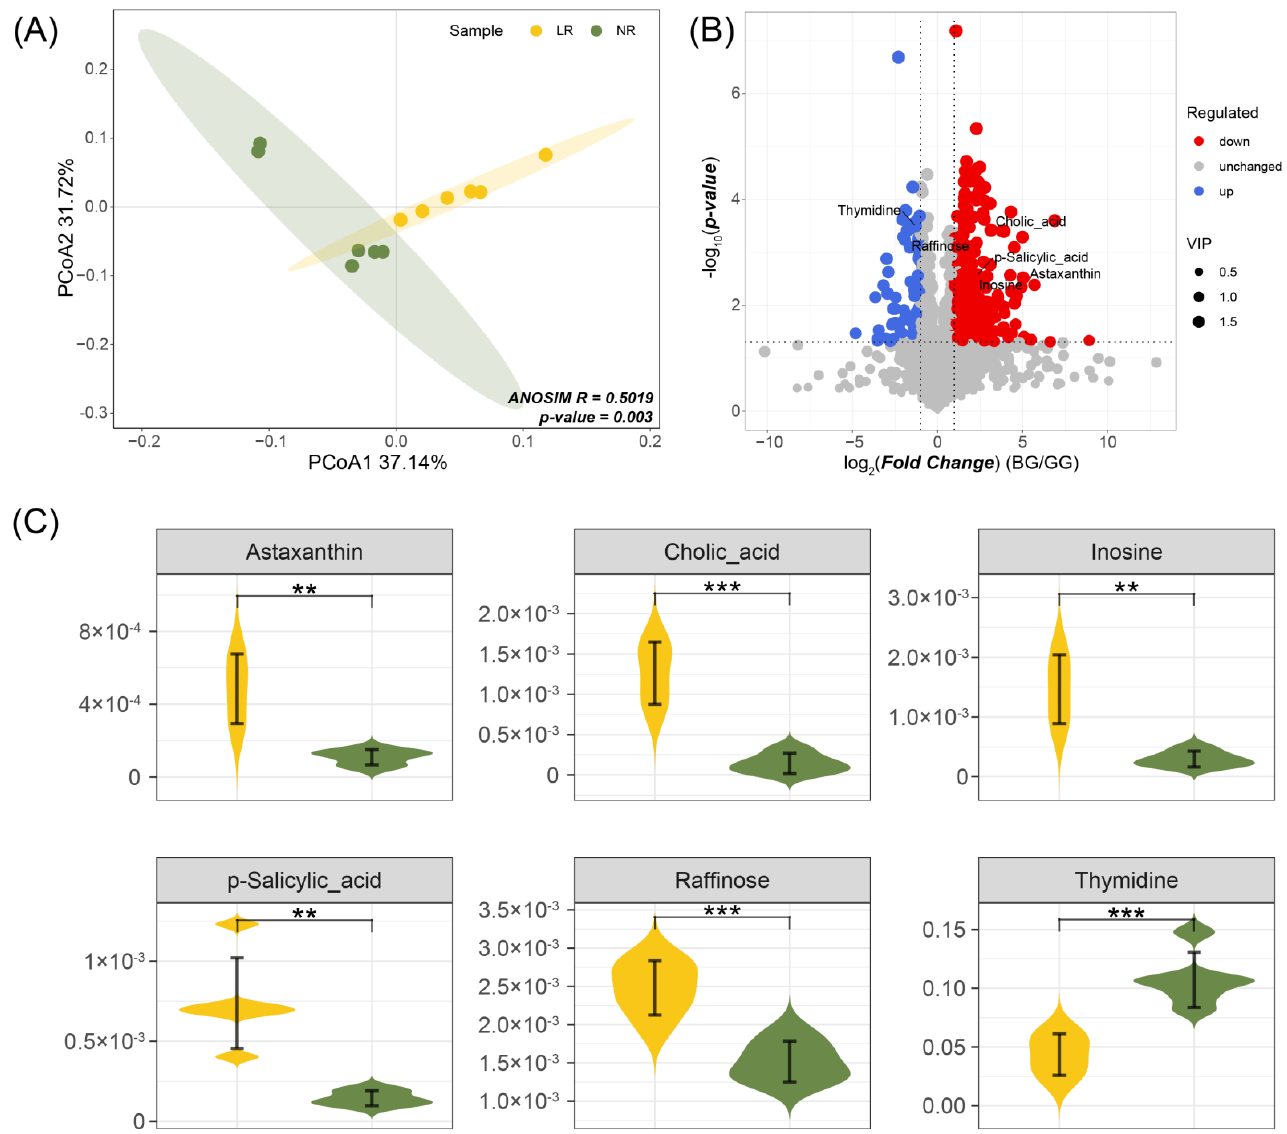
Figure 8. PCoA analysis of root metabolites of highbush blueberry with normal or limited growth. N-normally growing plants; L-plants with limited growth. ** p < 0.01, *** p < 0.001. The error bar represents the standard error value of three replicates. ( A ) Principal co-ordinates analysis of root metabolites. ( B ) Differential metabolite volcano map. ( C ) Changes in expression of differential metabolites.